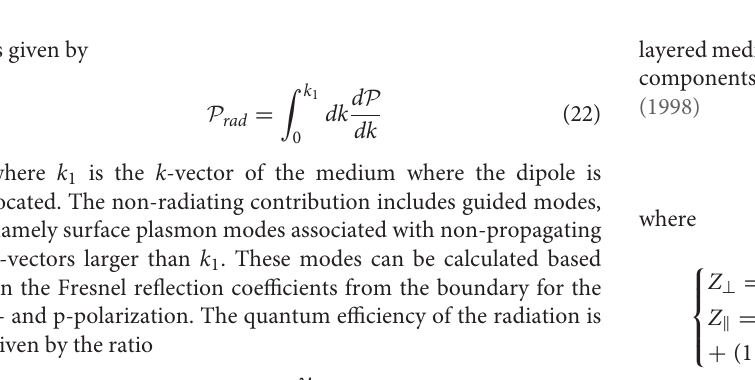
FIGURE 3 | Reflectance of coupled planar cavities presenting strong coupling with dependence on the refractive index of the first medium. At vertical incidence ( θ 0) the reflectance is independent of the refractive index of the first medium, but for angles larger then 30 ◦ fast deflection of the lower curve arises. =